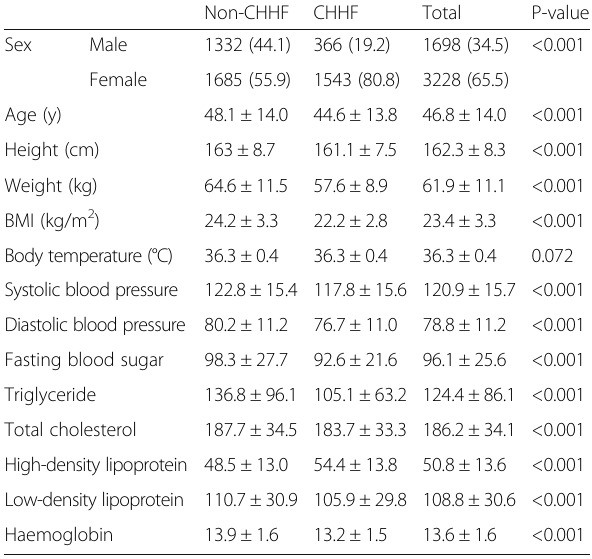
Table 1 Participant demographic characteristics and blood test